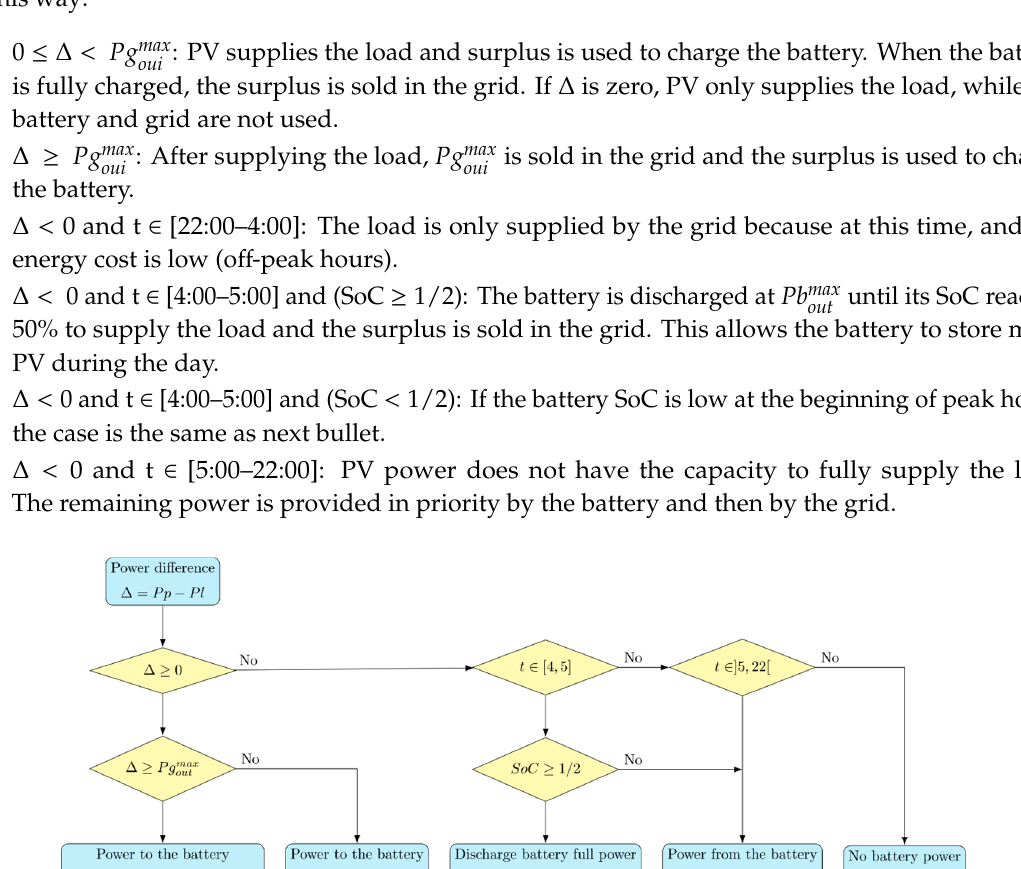
Figure 10. Flowchart of RBC3. As this strategy requires forecasting PV data, we proposed two versions: One with perfect forecasting which was used as a reference (RBC3r), and one with real forecasting model (RBC3). The real forecast of PV power was realized using an Auto Regressive Mobile Average (ARMA) method [48], which was tested and validated on the site. Compared with 10 others statistical and